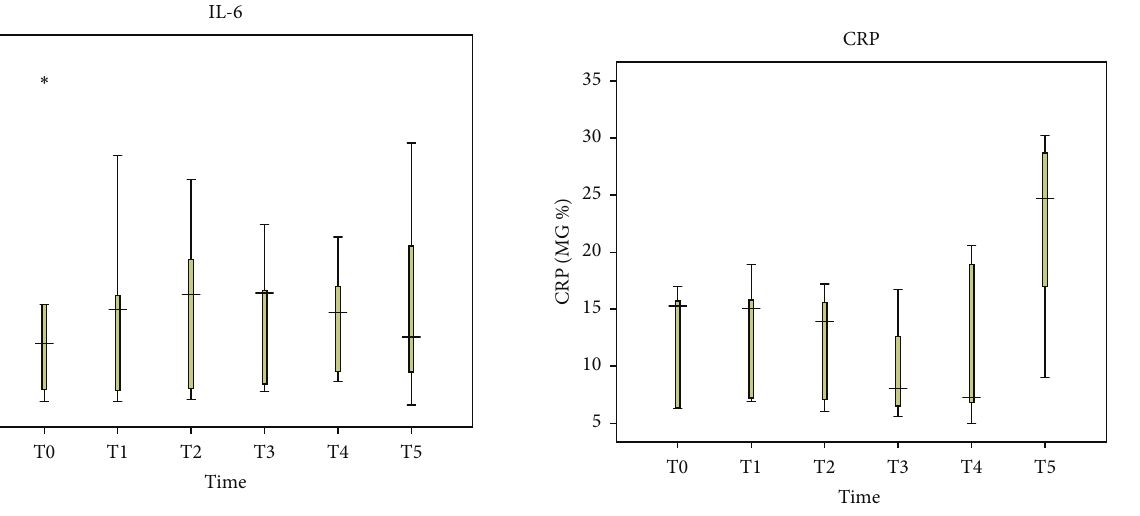
Figure 2: Perioperative interleukin-six (IL-6) levels in blood plasma.